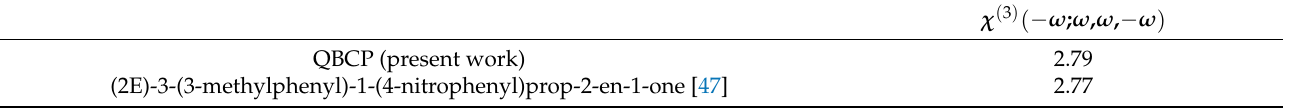
Table 8. The third-order nonlinear susceptibility ω = 0.086 a . u . (532